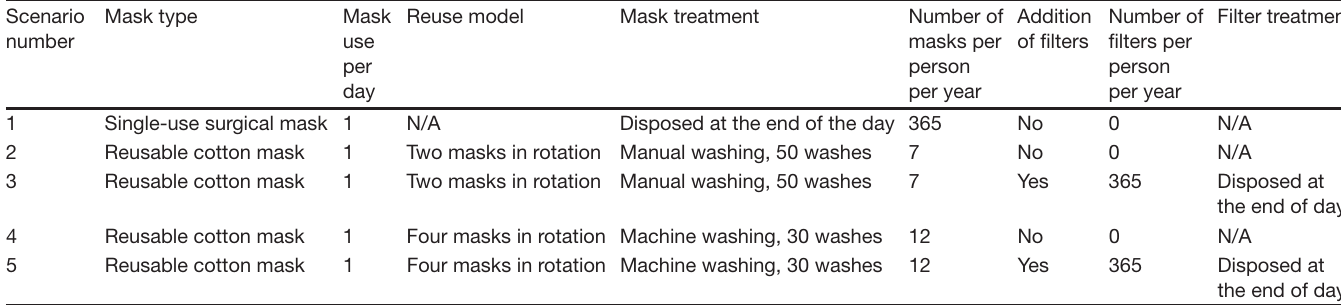
Table 3. Summary of five UK-wide face mask adoption scenarios considered in the comparative study. Scenario Mask number